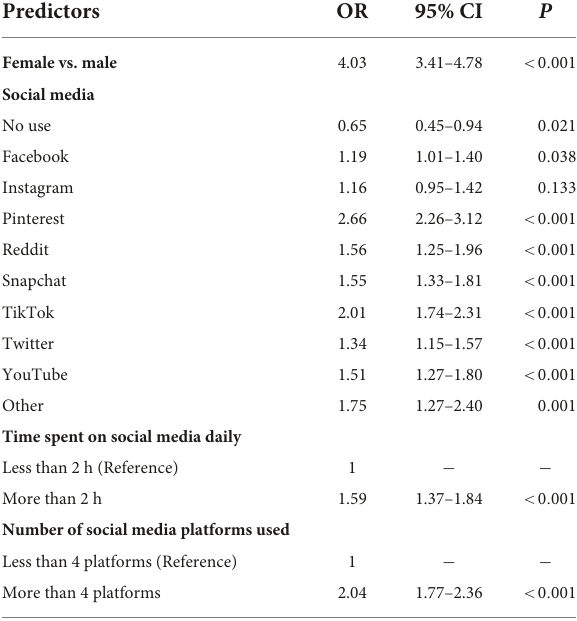
TABLE 3 Odds ratios for self-reported body image issues